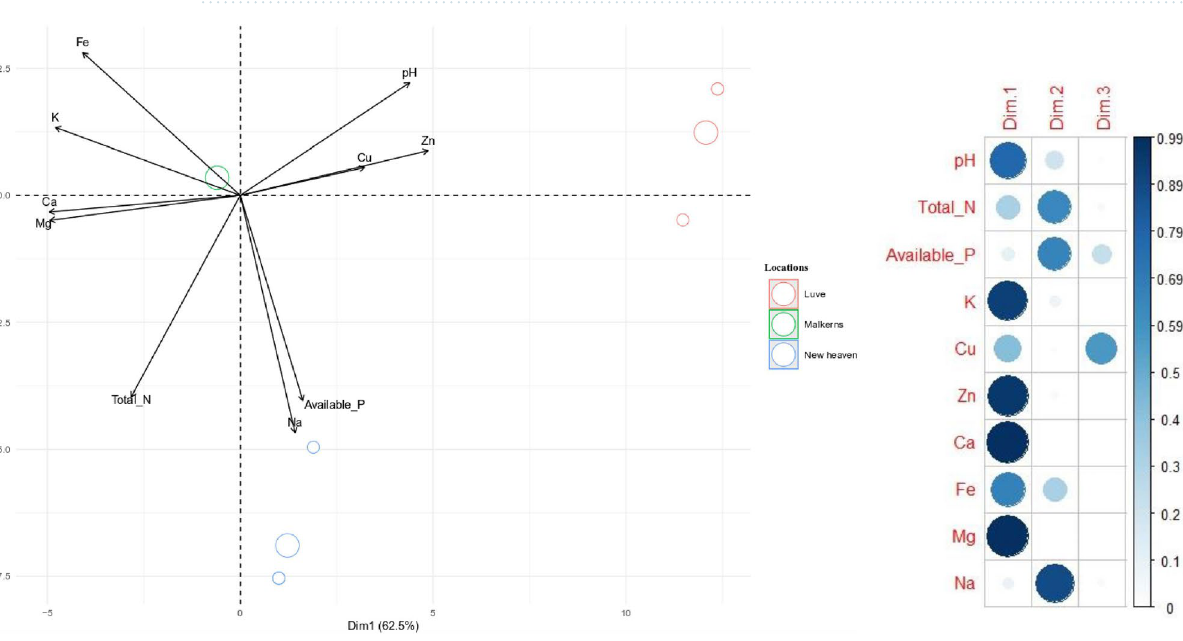
Figure 2. A PCA analysis showing the influence of soil chemical parameters on the distribution of rhizobial symbionts of groundnut, jack bean and soybean from three locations (Malkerns, Luve and New Heaven) in